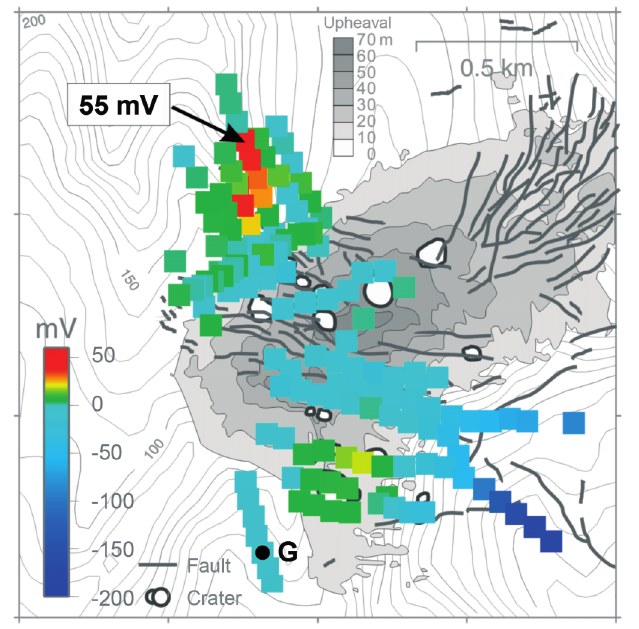
Fig. 6c. Temporal variation of self-potential anomalies relative to the reference station G: March, 2002.